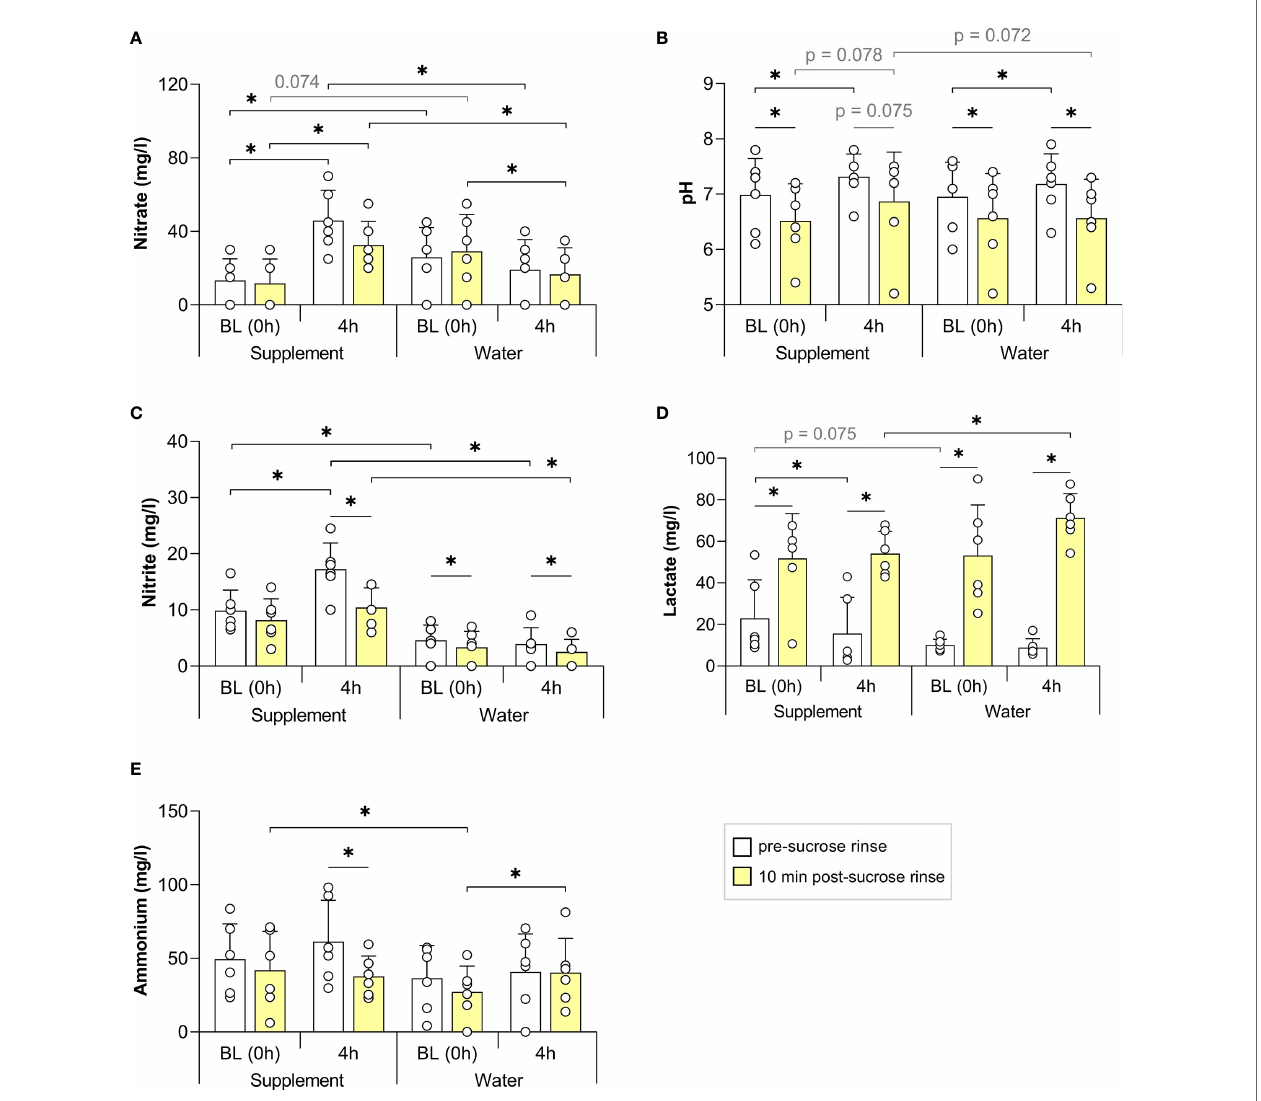
FIGURE 6 | The effect of a nitrate-rich supplement on sucrose rinses 4 h after intake compared with water. In 6 individuals, salivary nitrate (A) , pH (B) , nitrite (C) , lactate (D) and ammonium (E) were measured. Sugar rinses were performed at baseline (BL, 0 h) of the two different days (supplement day and water day) and 2 h after intake of a nitrate-rich supplement (220 mg nitrate in 200 ml) or water (200 ml). Saliva samples were collected immediately prior to the sugar rinse (pre-sucrose, white bars) and 10 min after the sugar rinse (post-sucrose, yellow bars). The bars and small white circles represent the averages and individual data, respectively. Wilcoxon tests were used to compare the pre-sucrose with the post-sucrose measurements. Additionally, the BL pre- and post-sucrose measurements were compared with 2 h pre- and post-sucrose measurements, respectively. Finally, every measurement of the supplement day was compared with the same measurement on the water day. Signi fi cant changes (*p < 0.05) and trends (grey text, p = 0.05 - 0.1) are